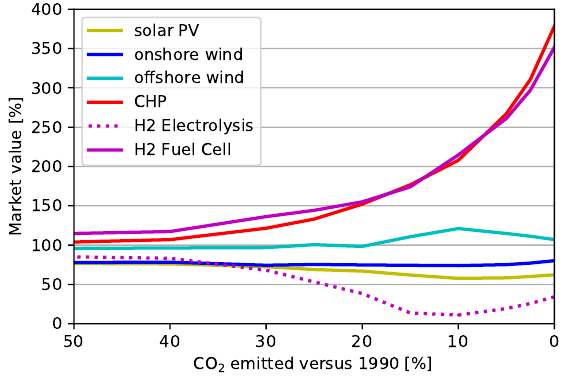
Figure 10. Market values relative to the average load-weighted